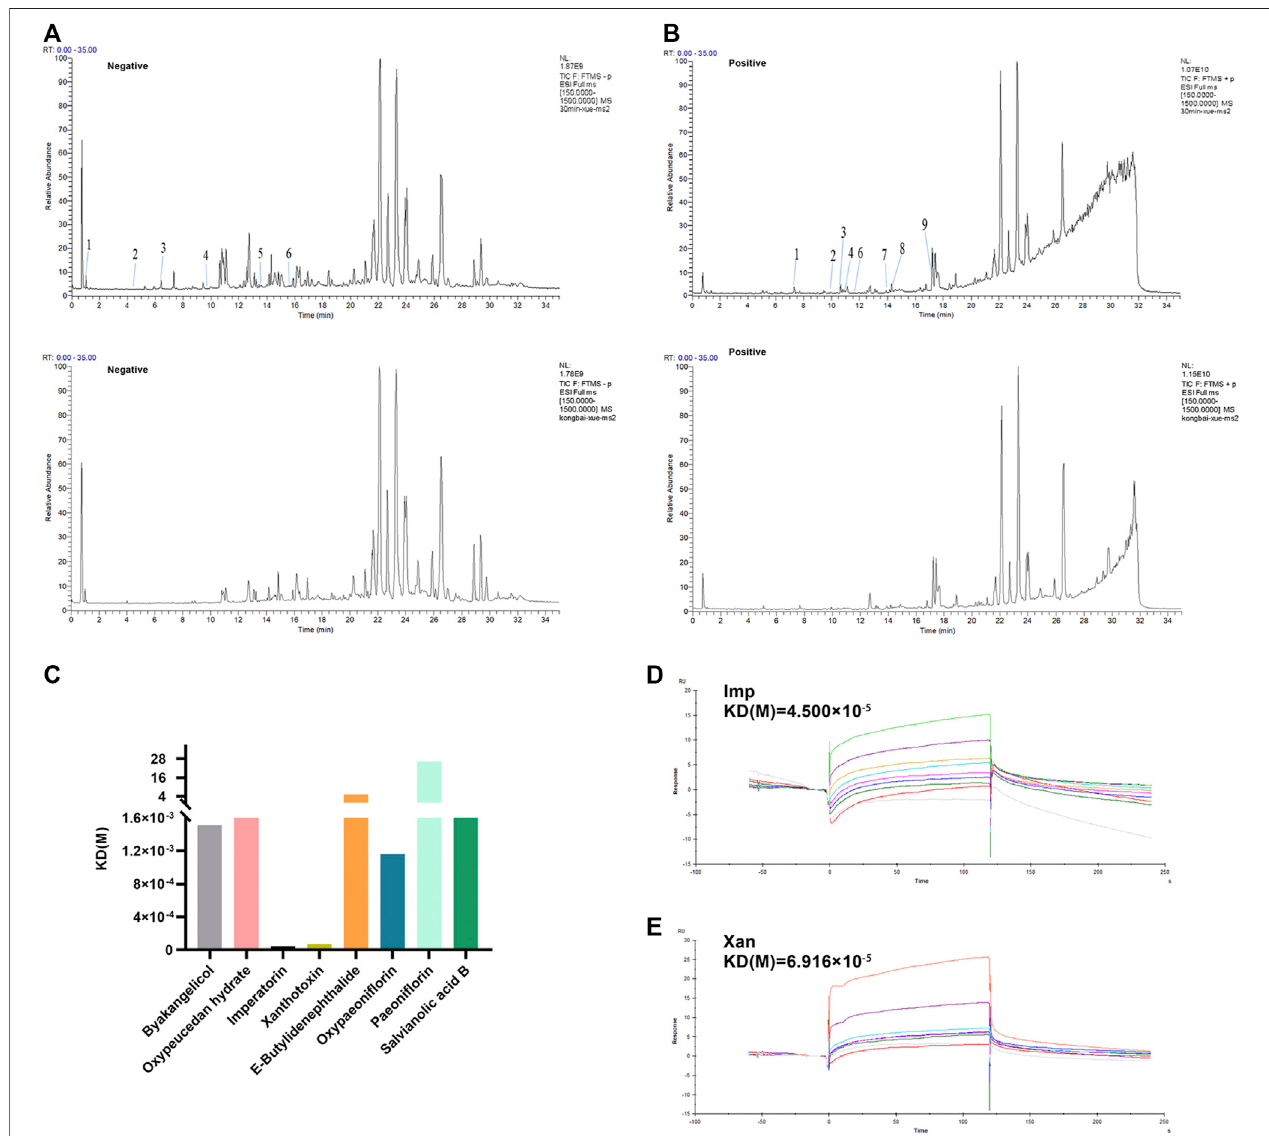
FIGURE 8 | Analysis of candidate targets of XZR against migraine. (A) Chromatographic and mass spectral data of the chemical compounds of XZR in the serum analyzed byUHPLC-LTQ-Orbitrap MS (negative mode) (top: serum sample acquired after XZR administration; bottom: blank serum sample. The details of Nos. 1 – 6 are listed in Supplementary Tables S3 . (B) Chromatographic and mass spectral data ofthe chemical compounds ofXZR in the serum analyzed by UHPLC-LTQ-Orbitrap MS (positive mode) (top: serum sample acquired after XZR administration; bottom: blank serum sample. The details of Nos. 1 – 9 are listed in Supplementary TablesS4 . (C) Biacoreanalysisofeightcompoundsidenti fi edinserumboundtonNOS(Gly468 – Leu616). (D) BiacoreanalysisofIMPboundtonNOS(Gly468 – Leu616). (E) Biacore analysis of XAN bound to nNOS (Gly468 – Leu616). XZR, Xiongshao Zhitong Recipe; Imp, imperatorin; Xan, xanthotoxin.